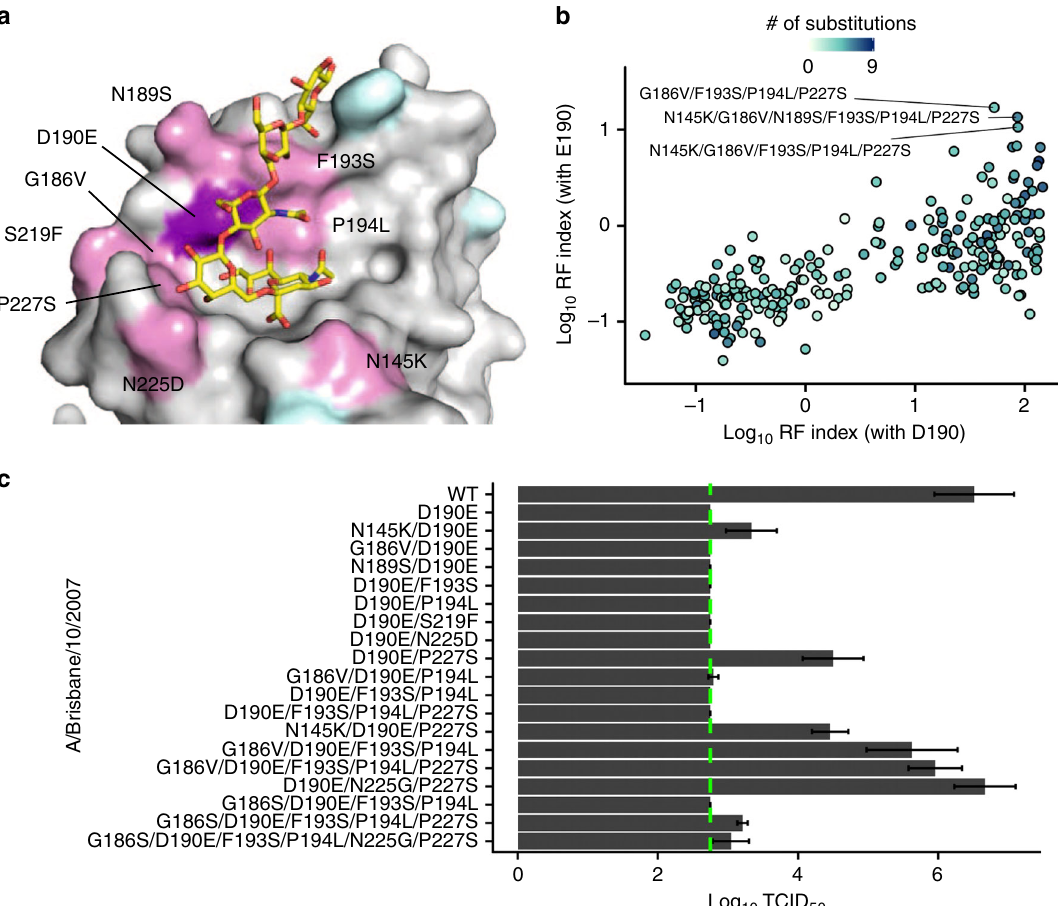
Fig. 2 Compensatory mutations for the deleterious effect of D190E in Bris07 HA. a Substitutions that represent reversions from Bris07 to Wy03 are highlighted in pink or cyan. Pink: residues included in the deep mutational scanning experiment. Cyan: residues not characterized in this study. Purple: residue 190. The receptor analog LS-tetrasaccharide c (LSTc) is colored in yellow. PDB 2YP4 (ref. 9 ). b Potential compensatory substitutions of Bris07 D190E were probed by deep mutational scanning. Each datapoint represents a certain combination of substitutions. The position along the y -axis represents the log 10 RF index for the indicated combination of substitutions plus D190E, whereas position along the x -axis represents the log 10 RF index for the indicated combination of substitutions by themselves (without D190E). c Effect of different combinations of substitutions on Bris07 replication fi tness was examined by virus rescue experiment. Virus titer was measured by TCID 50. Error bars indicate the standard deviation of three independent experiments. The green dashed line represents the lower detection